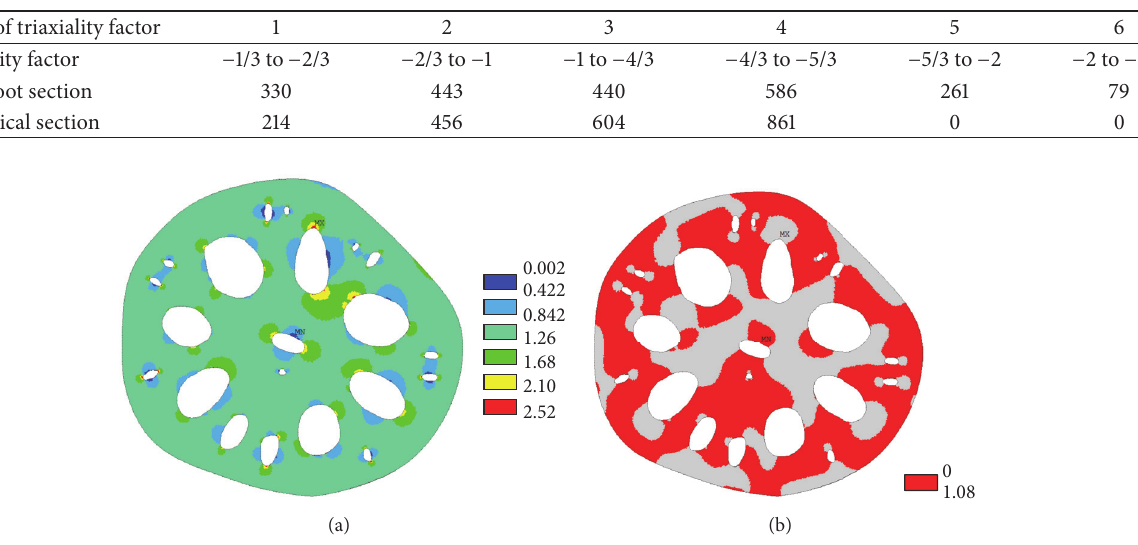
Table 3: Area of groups of triaxiality factor (mm 2 ).